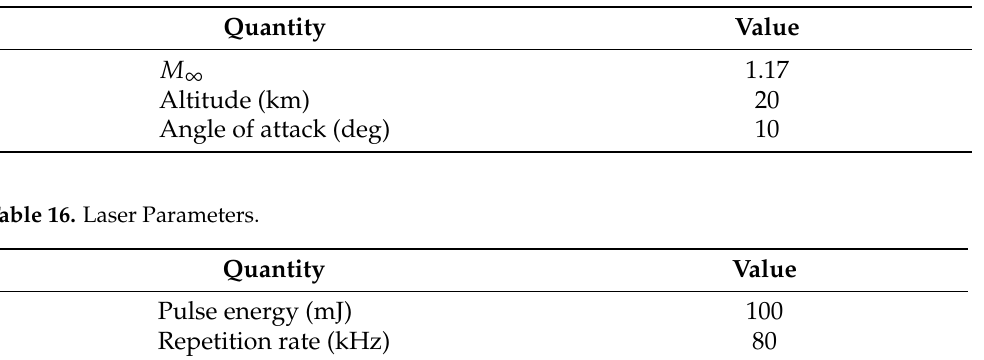
Table 17. A Nd:YAG laser was focused on the surface of a flat plate at distances from 10 mm